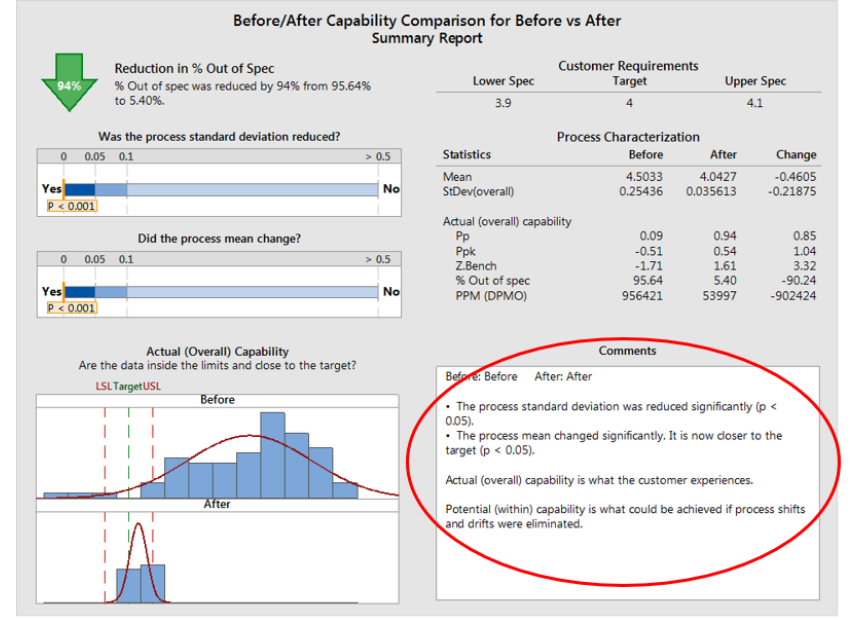
Figure 22. Performance report. Table 9. The number of scraps obtained after the implementation of the solutions.